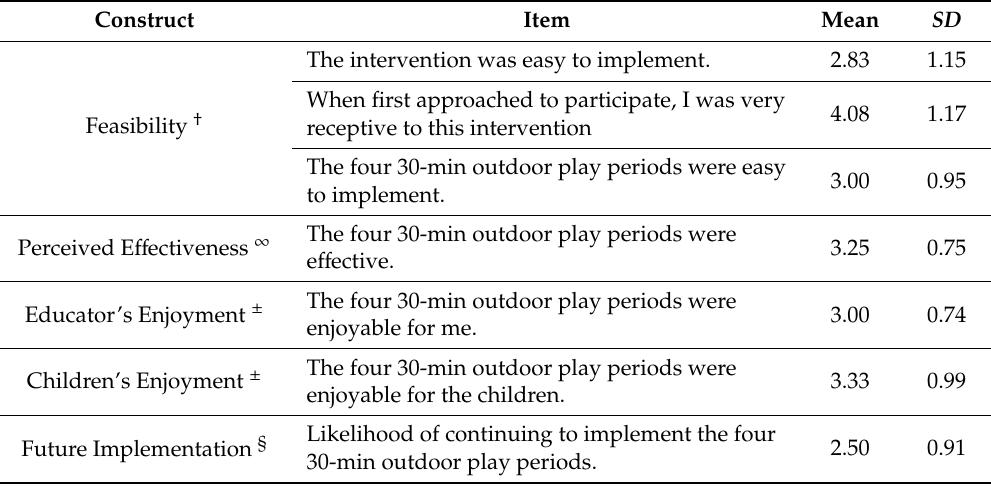
Table 5. Childcare providers’ mean (SD) rating of intervention feasibility, e ff ectiveness, enjoyment, and future